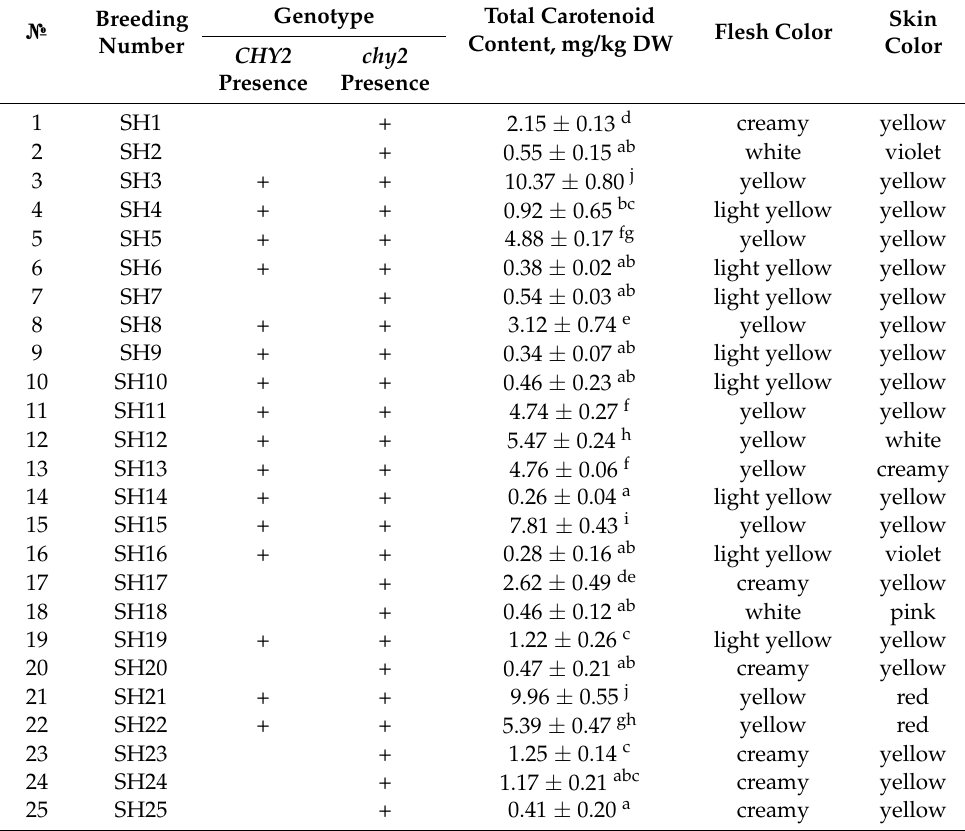
Table 4. Allelic composition at the Chy2 locus, total carotenoid contents and color of the